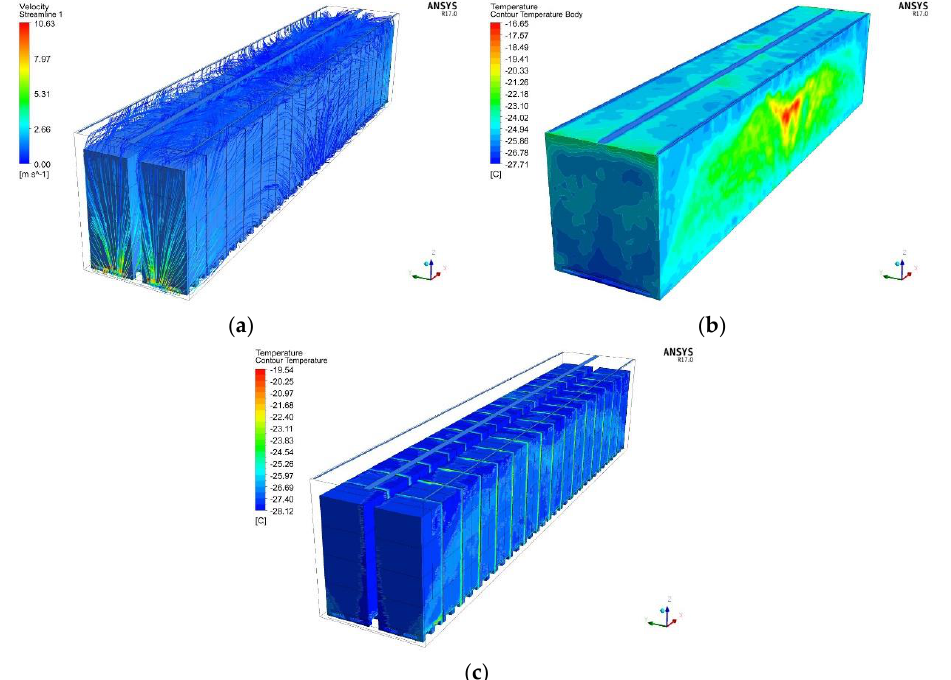
Figure 7. The stationary model of turbulent flow, method: RSM ( a ) streamline: velocity magnitude (m/s), ( b ) external temperature (°C) distribution, ( c ) internal temperature (°C) distribution.